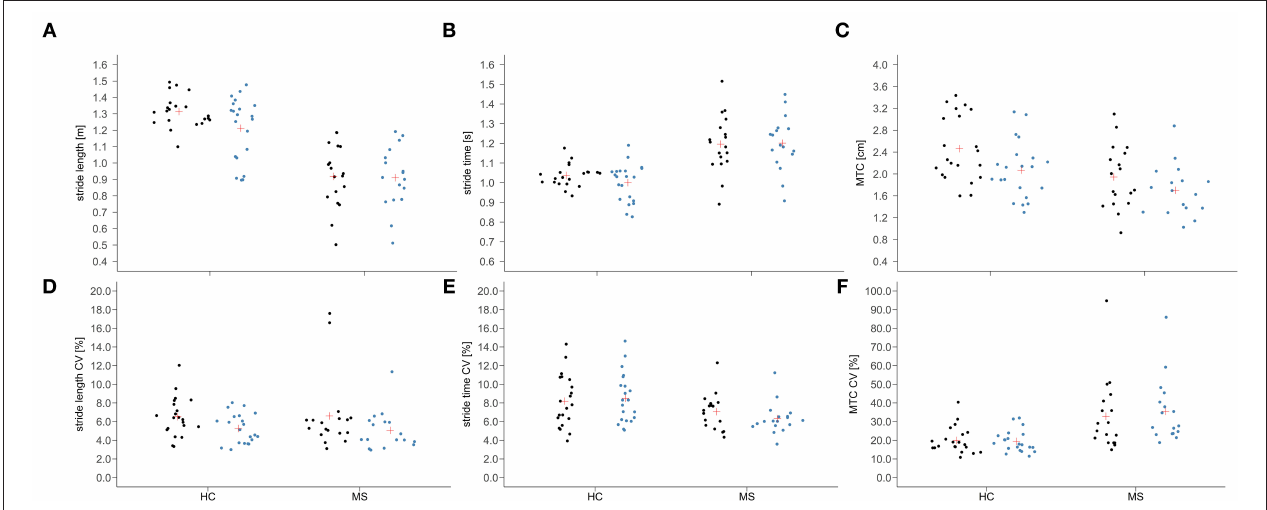
FIGURE 2 | Individual data (dots) and means (red cross) of stride length (A) , stride time (B) , and minimum toe clearance [MTC; (C) ] as well as their coefficient of variation [CV; (D–F) ] before (black) and after (blue) the fast 6-min walk test in people with multiple sclerosis (MS) and healthy controls (HC).